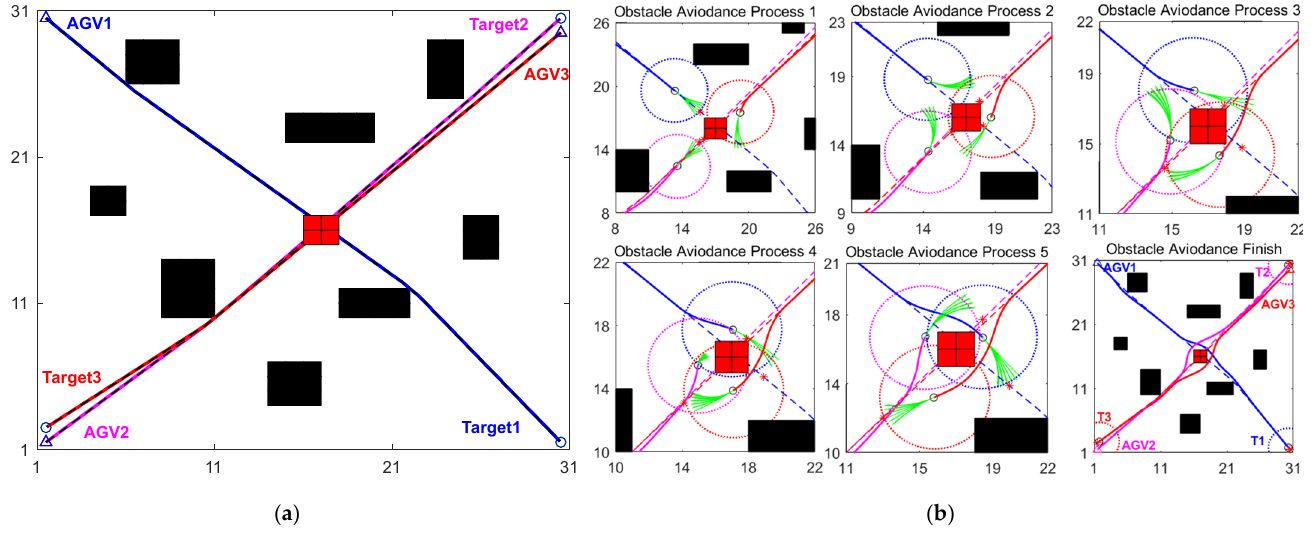
Figure 23. Multi-robot path planning 2. ( a ) Global path planning. ( b ) Robot local motion. Table 8. Multi-robot path planning results in an unknown static environment.